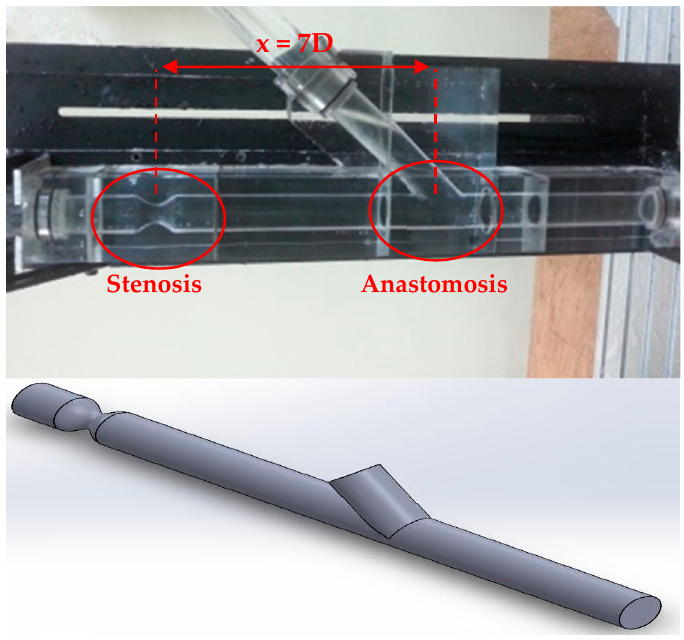
Figure 2. Experimental part and 3D geometry of the aorta with stenosis and anastomosis